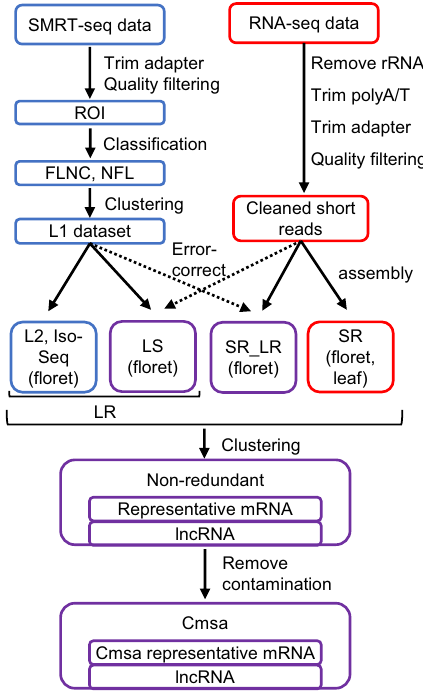
Figure 1. Flow of dataset preparation and analysis. SMRT-seq raw reads were processed into ROI, classified into FLNC and NFL sequences, and clustered into the L1 dataset. The L1 dataset was further quality filtered into the L2 dataset. The L1 dataset was also error-corrected with cleaned short reads to produce the LS dataset. RNA- seq data were cleaned and used for de novo assembly. The L2, LS, SR_LR, and SR datasets were combined and clustered into one non-redundant dataset. The contaminated sequences were removed from the non-redundant dataset. The final dataset was named the Cmsa dataset and deposited in the DDBJ database. ROI: reads of